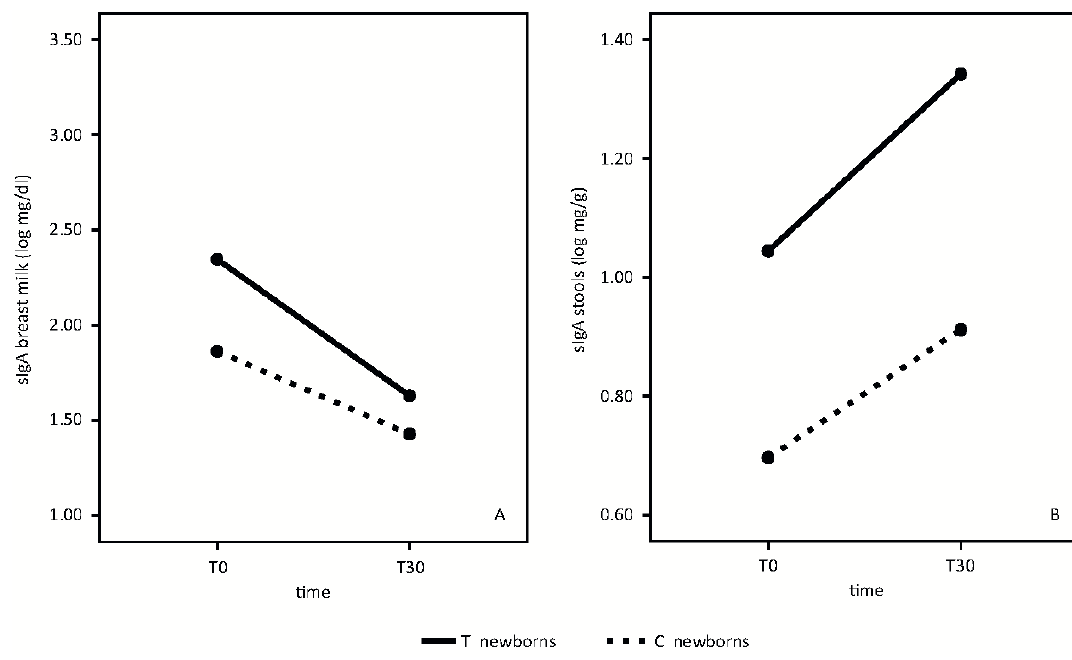
Figure 3. Secretory IgA (sIgA) in breast milk and stools, in treatment (T) and control (C) groups at observational times T0 and T30. ( A ) (Secretory IgA (sIgA) mean values in breast milk); ( B ) (Secretory IgA (sIgA) mean values in stools).